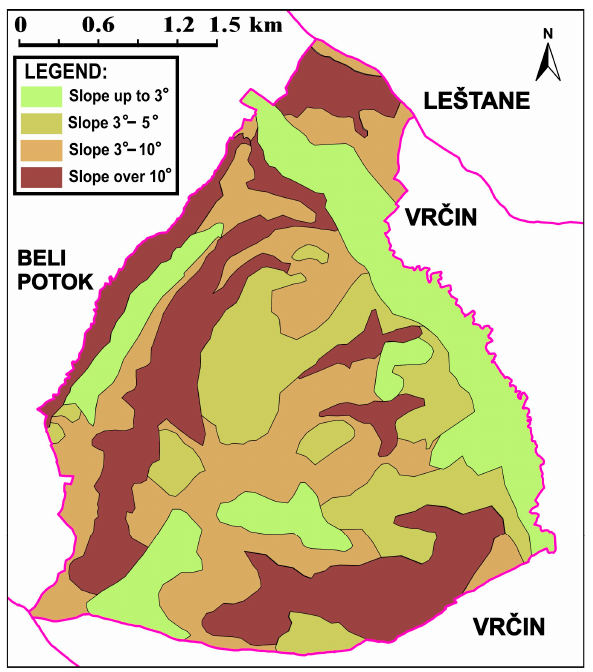
Figure 3. Example of a terrain slope map for the settlement of Zuce.